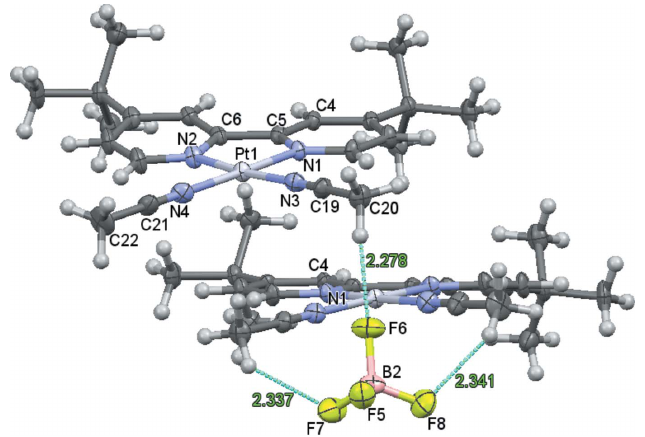
Figure 1 Displacement ellipsoid plot (50% probability of all non-H atoms), illustrating the head-to-head dimer with selected H (cid:2)(cid:2)(cid:2) F intermolecular distances (A˚ ) between a BF 4 (cid:4) anion and acetonitrile molecules on adjacent molecules.